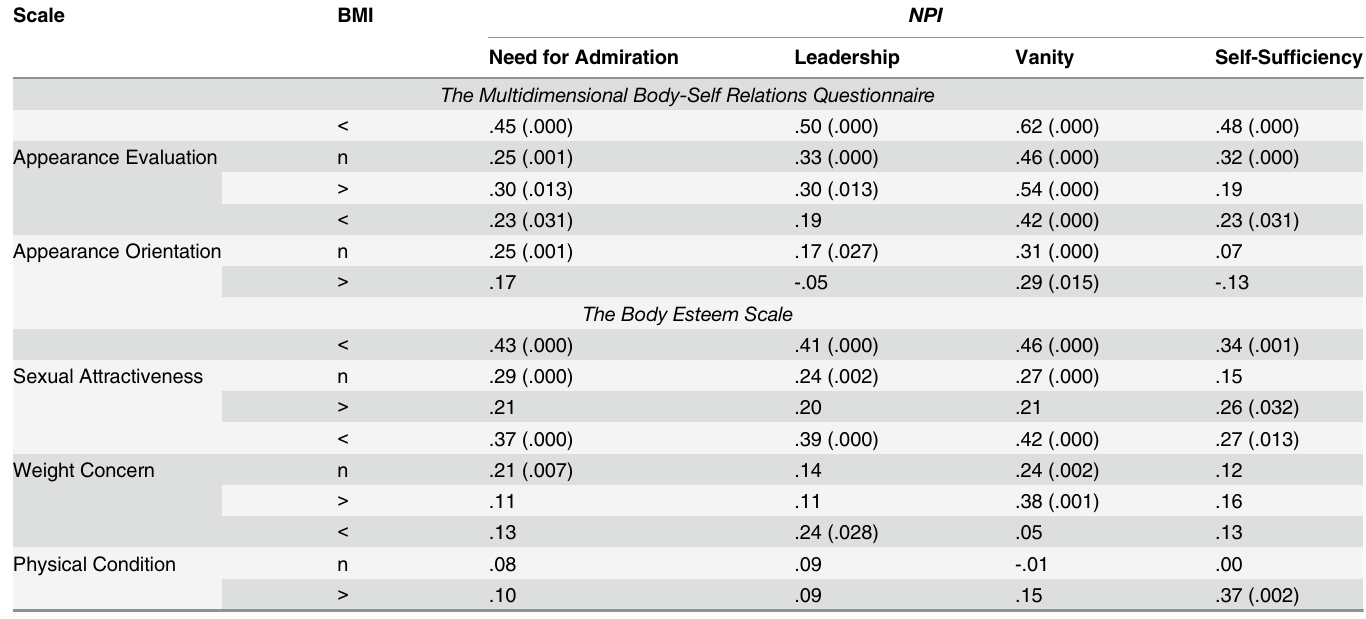
Table 4. Correlations between the scales of self-image (BSE and MBSRQ) and the narcissistic traits (NPI) of women with various